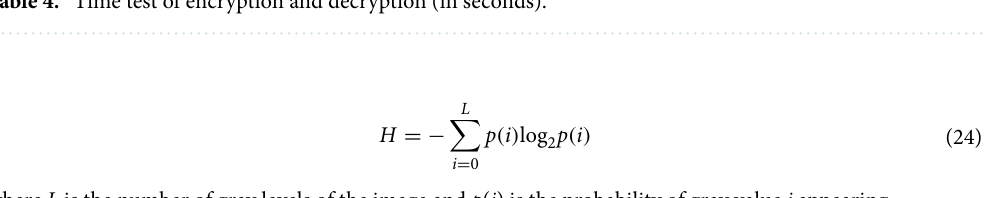
Table 4. Time test of encryption and decryption (in